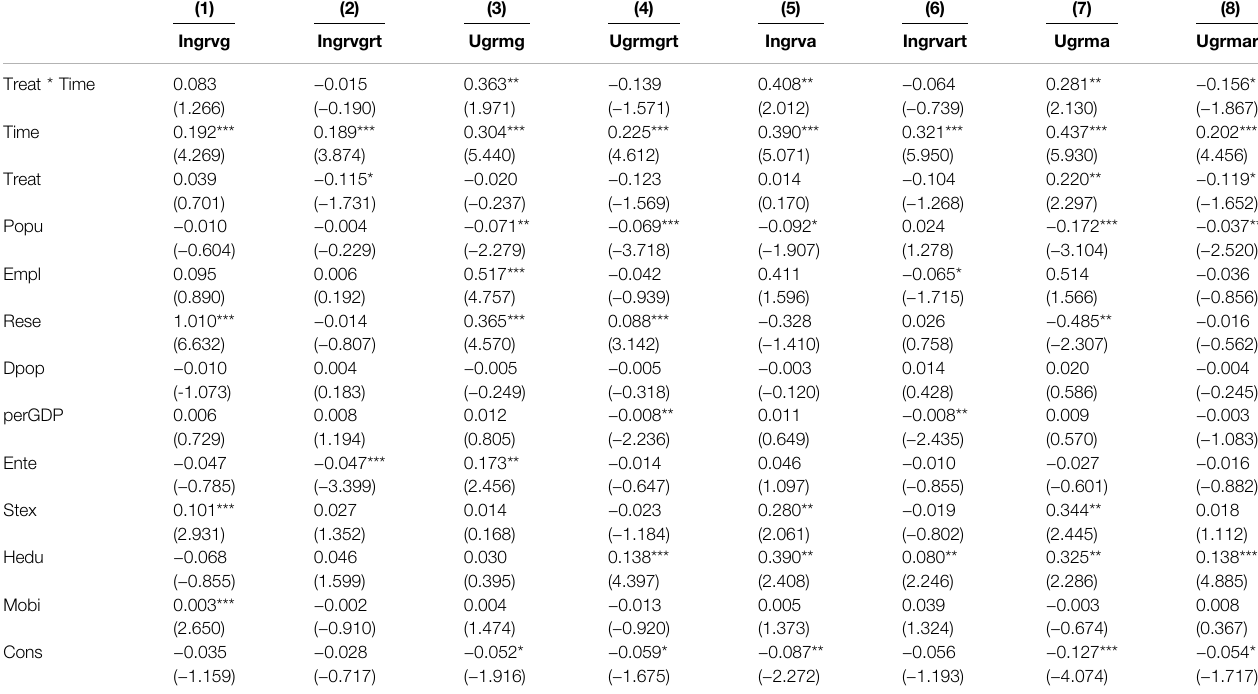
TABLE 6 | Regression results after changing the explanatory variable